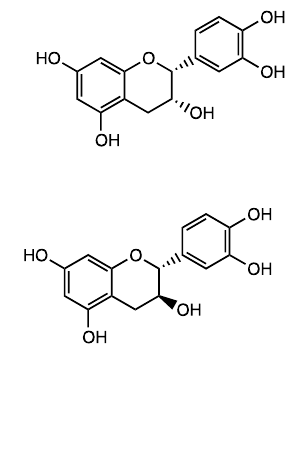
Figure 12. Catechins and proanthocyanidins (above) and limonoids (below) from Xylocarpus granatum